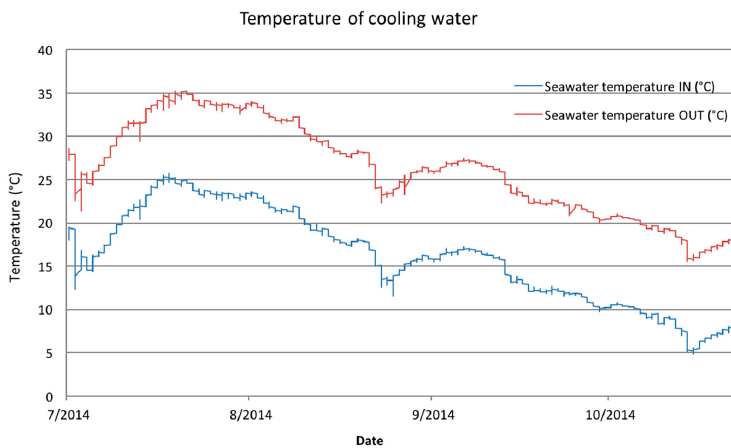
Figure 2. Temperature of seawater used for cooling (IN) and temperature of the seawater after cooling circle (OUT). circle